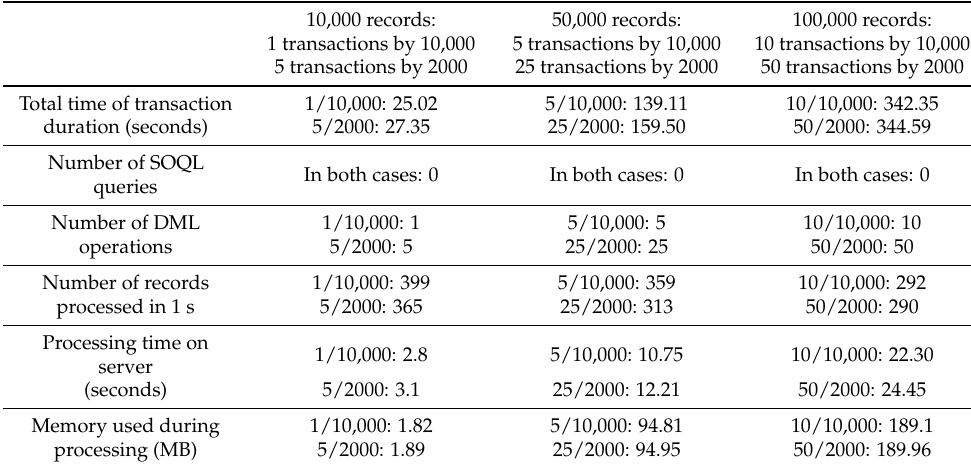
Table 4. Future Apex processing results for insert operation.